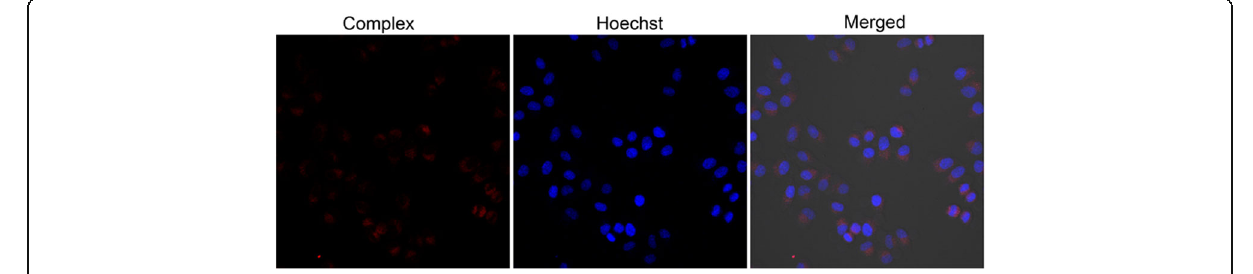
Fig. 7 Fluorescent images of A549 cells treated with PEI-Ada@Ru-CD/DNA for 8 h at an N/P ratio of